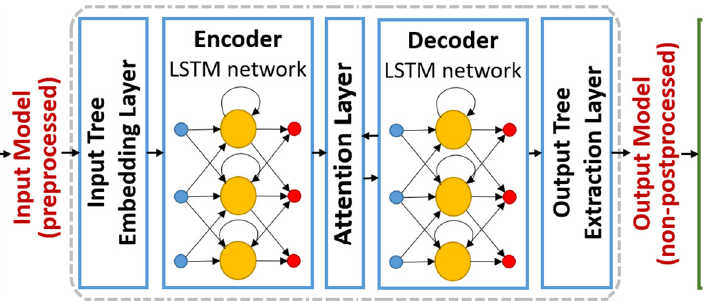
Figure 2. The architecture of the LSTM model (www.modelling-languages.com/lstm-neural-network-model-transformations/ (accessed on 22 December 2021)).